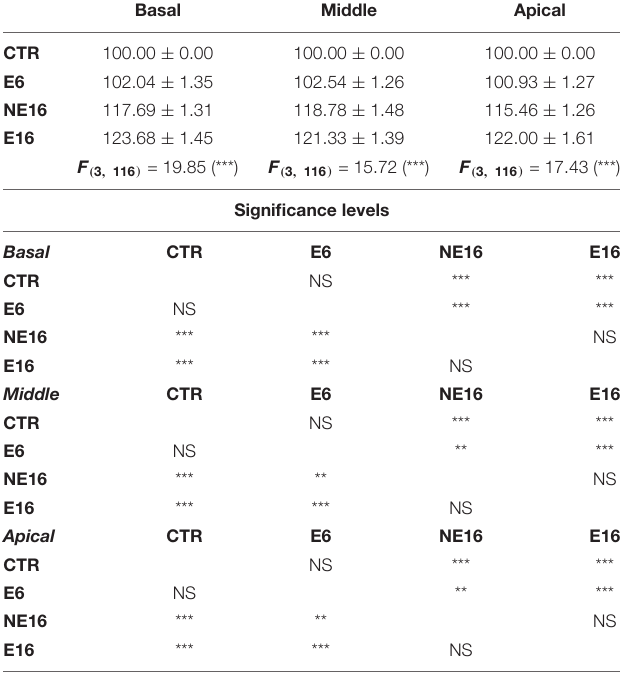
control condition.